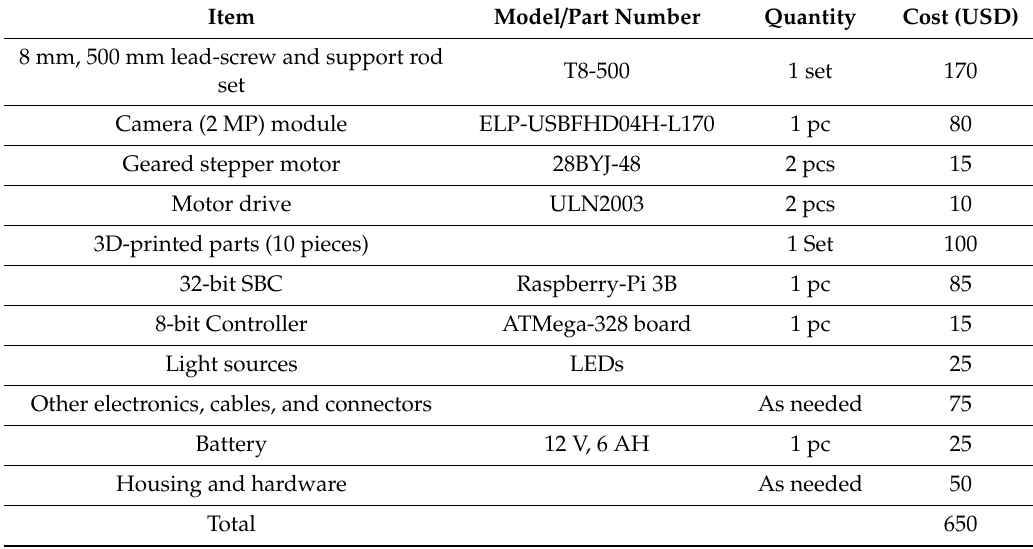
Table 4. Cost detail for the first prototype of the proposed system (solar backup system is not included). Item Model / Part Number Cost (USD) 8 mm, 500 mm lead-screw and support